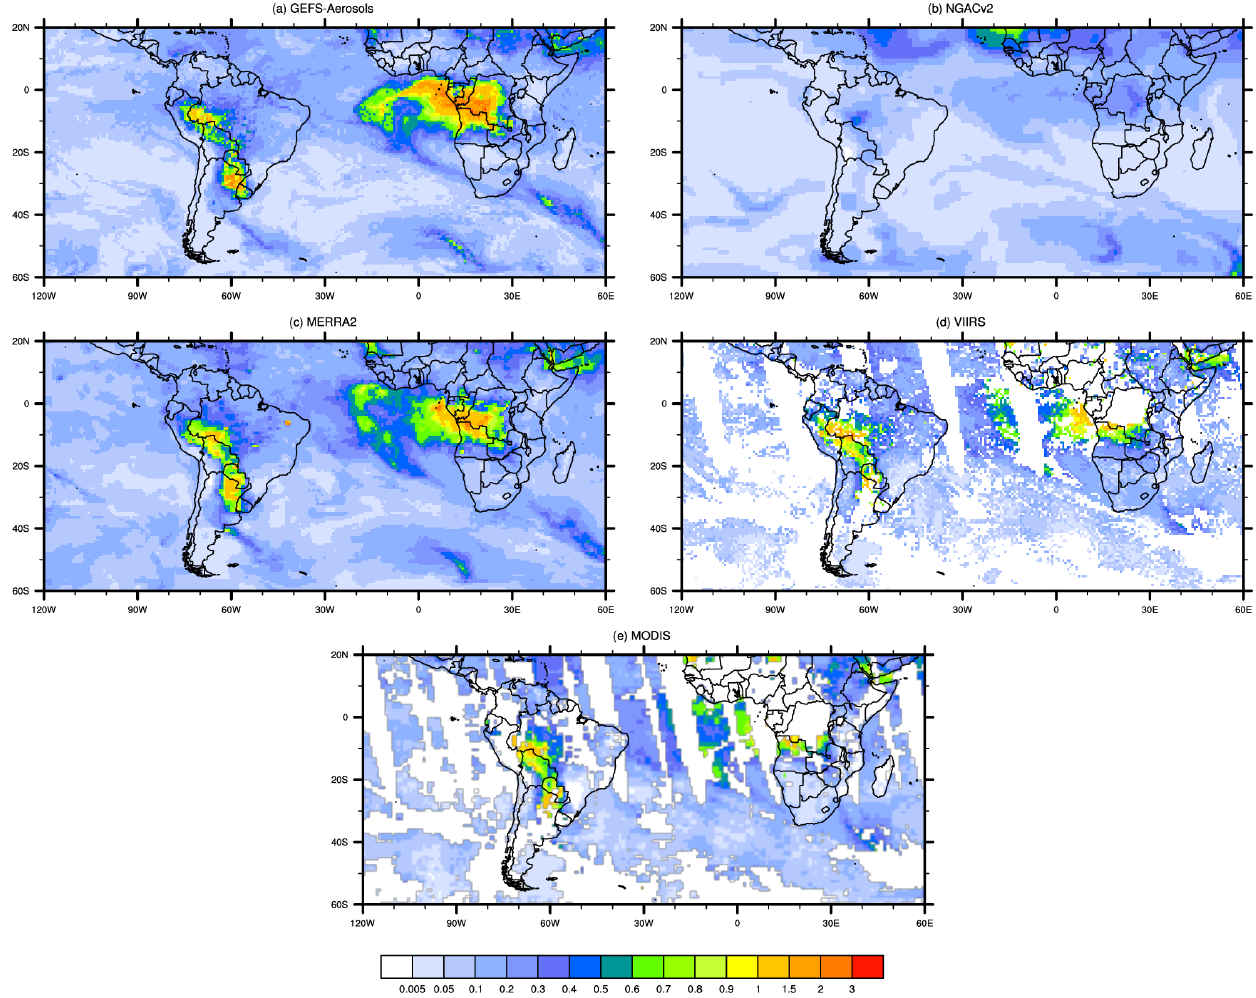
Figure 4. Total AOD forecast on 25 August compared to the NGACv2 model, MERRA-2 reanalysis data, and satellite observations of VIIRS and MODIS. The 18:00 forecasts from both models for that day and daily satellite data are used in the figure. Satellite data gaps are in